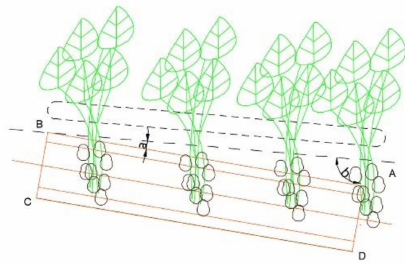
Figure 4. Schematic diagram of peanut picking process. a is the angle between the clamping conveyor chain and fruit picking rollers; b is the clamping angle between peanut plant and clamping